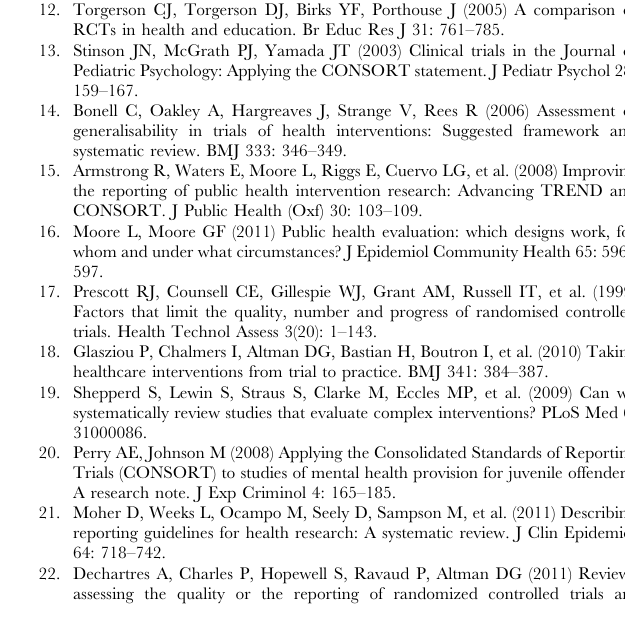
Table S1 Reported details of guideline development methods. Table S2 New and modified reporting standards for social and psychological intervention RCTs. Table S3 Frequency of compliance with reporting